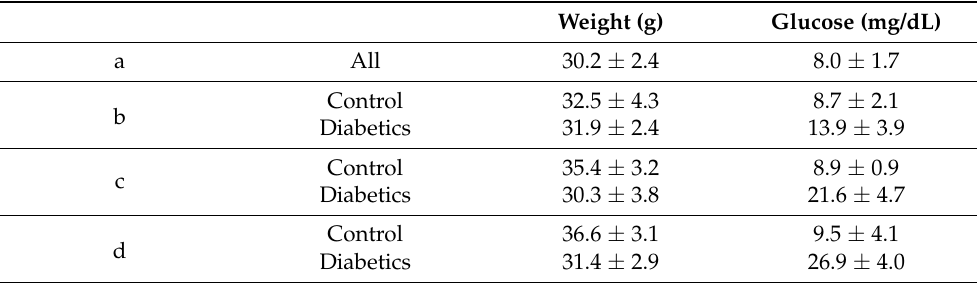
Table 1. Weight and blood glucose levels (Mean ± StD) in control and diabetic mice groups (n = 25 per